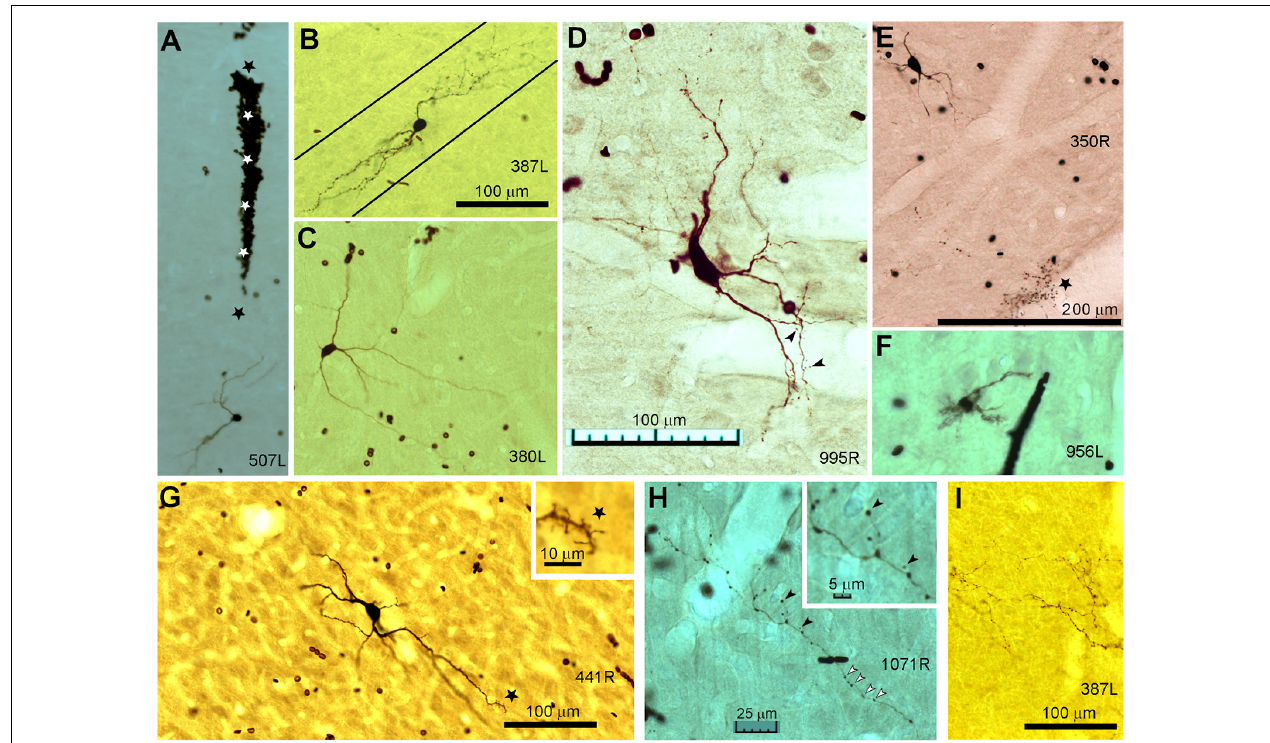
FIGURE 1 | Photomicrographs of biocytin labeled cells in the IC. (A) Blood-filled electrode track (marked by stars) directed at the soma of a small laminar disk cell (507L) viewed in the coronal plane. (B) Laminar elongated cell (medium size, 387L) with dendrites oriented along a single fibro-dendritic lamina, the orientation of which is shown by the two solid black lines in the coronal plane. (C) Medium sized, elongated stellate cell (380L) with dendrites that run across the fibro-dendritic laminae in the coronal plane. (D) Large flat disk cell (995R) viewed in the horizontal plane. This has sparse dendritic spines of the pedunculate type which are just visible at this magnification (see arrowheads). (E) Medium disk cell (350R, coronal plane) with an axon terminating in clusters of large synapses with a basket-like arrangement one of which is indicated by the black star. (F) Small multipolar cell (956L, horizontal plane) with short spiky dendrites and a bushy appearance that lacked an obvious axon. (G) Large spherical stellate cell (441R, coronal plane) showing relatively thick dendrites and sparse dendritic spines which are more common at the distal end (see star where the dendrite is shown at higher magnification in the inset). (H) Axonal swellings from a small flat laminar cell (1071R, horizontal plane). These can be at the end of short branches and are variable in size (black arrow heads shown at higher magnification in inset) but are more commonly en passant swellings (white arrow heads). (I) Examples of mainly en passant axonal swellings for a less flat ovoid cell with an extensive translaminar axon that crosses the commissure (387L). The scale bars for panels (A–C) are the same and the scale bar for panel (D) also applies to panel (F)